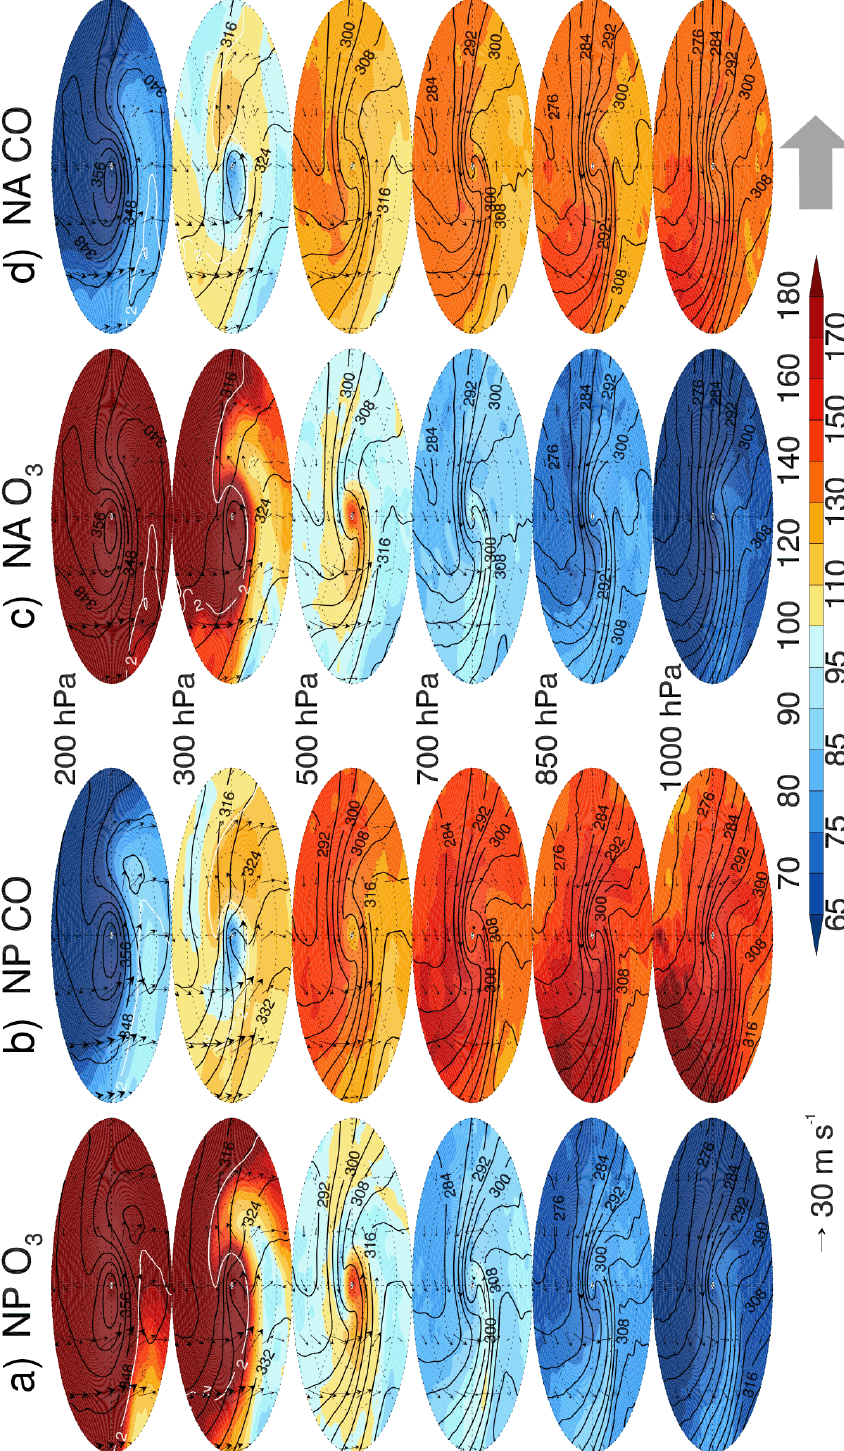
Figure 4. 95th percentile MAM storm tracks during 2003–2012 for (a, b) NP and (c, d) NA storm-centered composites of (a, c) O 3 , (b, d) CO (O 3 and CO color contours using same color bar, 5ppb intervals for cool colors and 10ppb intervals for warm colors), θ e (black contour lines; 4K intervals), and horizontal wind vectors (30ms − 1 , reference arrow) on five levels (1000, 850, 700, 500, 300, and 200hPa). Dynamical tropopause estimated by the isosurface of 2 PVU (solid white line). Storm propagation is toward the right as indicated by the large grey arrow. Radial dotted lines are plotted every 45 ◦ and dotted circles represent 5, 10, 15, and 20 ◦ radii from storm